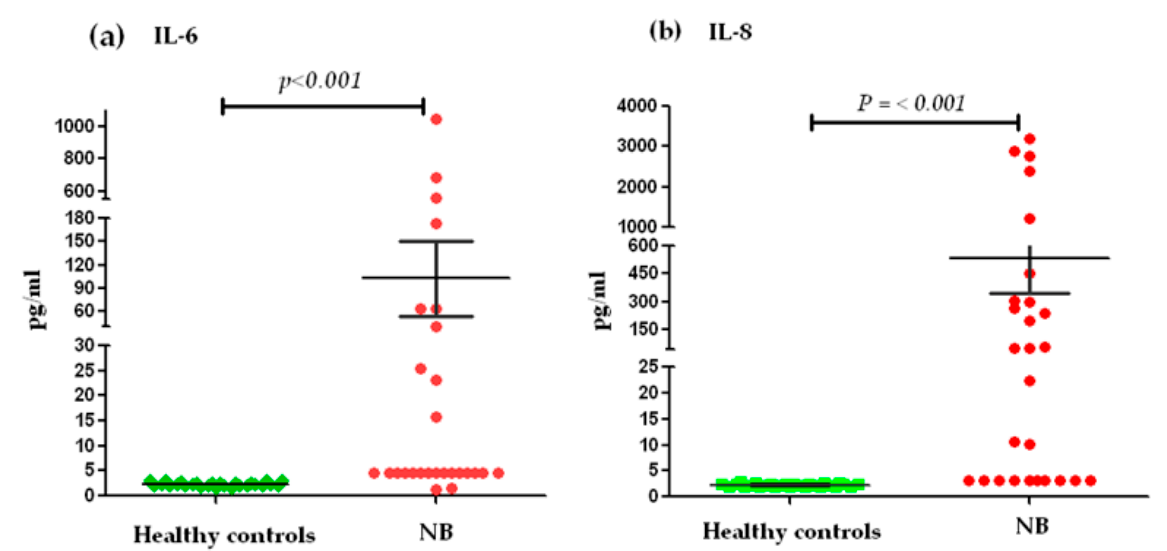
Figure 1. Serum IL-6 and IL-8 concentrations between NB cases and the control group: ( a ) Differences in IL-6 concentrations in pg/mL between the control group and patients with NB. ( b ) Differences in IL-8 concentrations in pg/mL between the control group and patients with NB. The comparison of serum concentrations between the control group and patients with NB for both cytokines was performed using the Wilcoxon test.